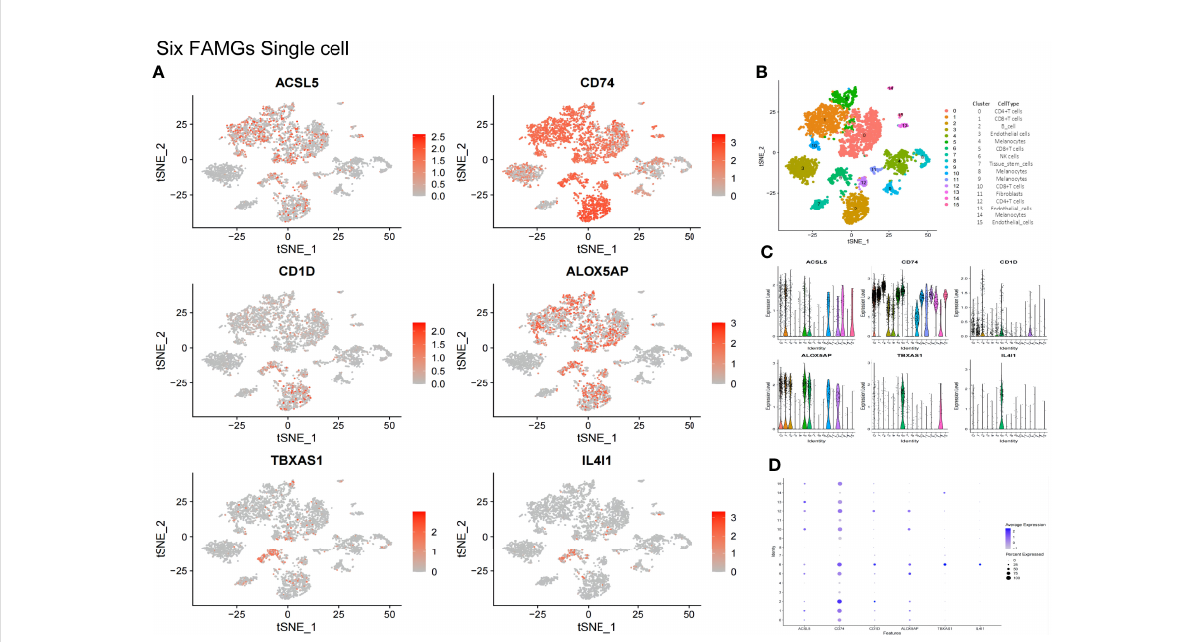
FIGURE 9 The expression of the 6 FAMGs was validated in a GEO single-cell cohort. (A) The expression levels of ACSL5, ALOX5AP, CD1D, CD74, IL4I1, and TBXAS1 were relatively high in the CD8 + T-cell, CD4 + T-cell, B-cell, and NK cell subsets. (B) Immunocyte annotation, Cluster 0, CD4+T cells; 1, CD8+T cells; 2, B cell; 3, Endothelial cells; 4, Melanocytes; 5, CD8+T cells; 6NK cells; 7, Tissue stem cells; 8, Melanocytes; 9, Melanocytes; 10, CD8+T cells; 11, Fibroblasts; 12, CD4+T cells; 13, Endothelial cells 14, Melanocytes;15, Endothelial cells. (B) A bubble chart of single-cell data shows the average and percent expression of ACSL5, ALOX5AP, CD1D, CD74, IL4I1 , and TBXAS1 . (C) A violin chart of single-cell data shows the expression levels of the 6 FAMGs. (D) A bubble chart of single-cell data shows the average and percent expression of ACSL5, ALOX5AP, CD1D, CD74, IL4I1 , and TBXAS1